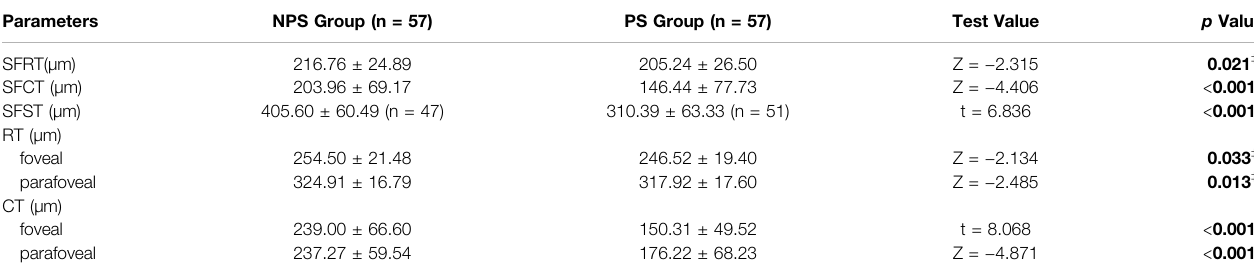
TABLE 2 | Comparison of RT, CT, and SFST in NPS group and PS group.